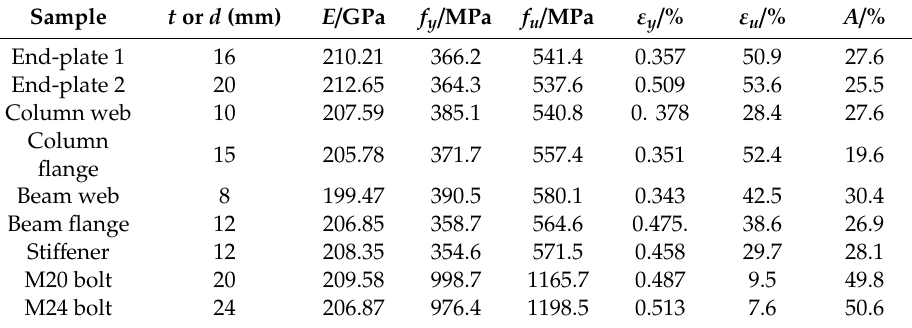
Table Note: t and d are the plate thickness and bolt diameter; E is the elastic modulus; f y and f u are the yield strength and tensile strength; ε y and ε u are the corresponding yield strain and tensile strain; A is the elongation after break rate.